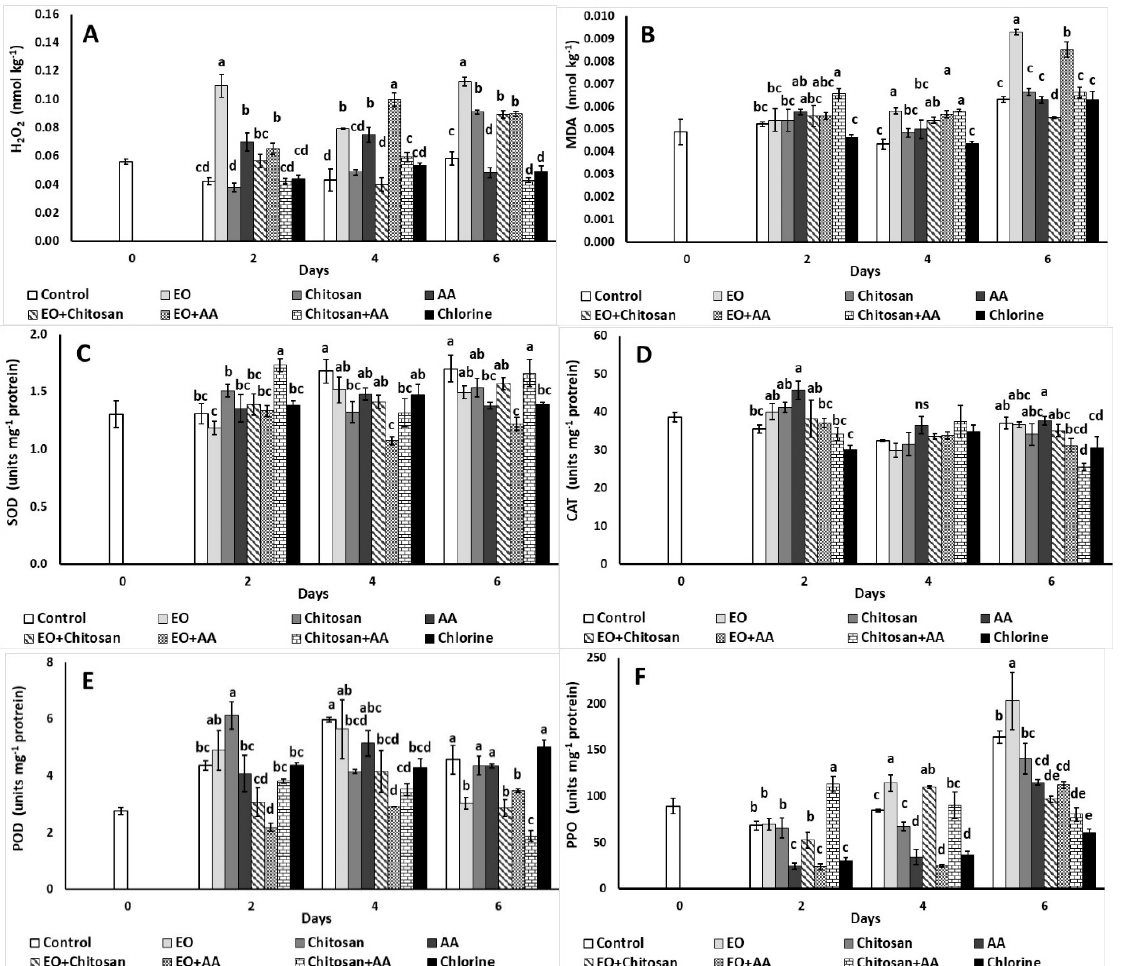
Figure 7. Effect of marjoram essential oil (EO), chitosan, and ascorbic acid (AA) on fresh-cut lettuce on ( A ) H 2 O 2 production (nmol kg − 1 ), ( B ) lipid peroxidation (nmol kg − 1 ) and antioxidant enzymes activity of ( C ) superoxide dismutase (SOD; units mg − 1 protein), ( D ) catalase (CAT; units mg − 1 protein), ( E ) peroxidase (POD; units mg − 1 protein), and ( F ) polyphenol oxidase (PPO; units mg − 1 protein) after treatment and 6 days of storage at 7 °C and 90% RH. On the columns, significant differences ( p < 0.05) among treatments are indicated by different Latin letters; ns indicates no significant differences for different days. Values represent means (±SE) of measurements made on three biological replicates per treatment.